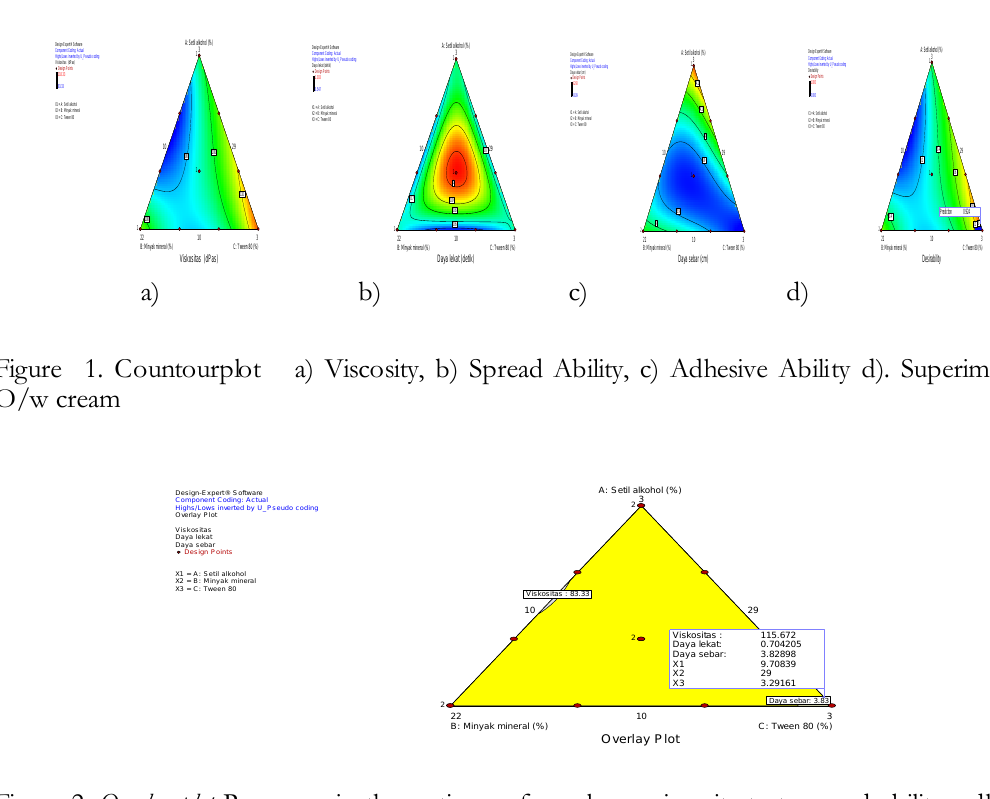
Figure 2. Overlay plot Response in the optimum formula on viscosity test, spread ability, adhesive ability Mahkota Dewa o/w